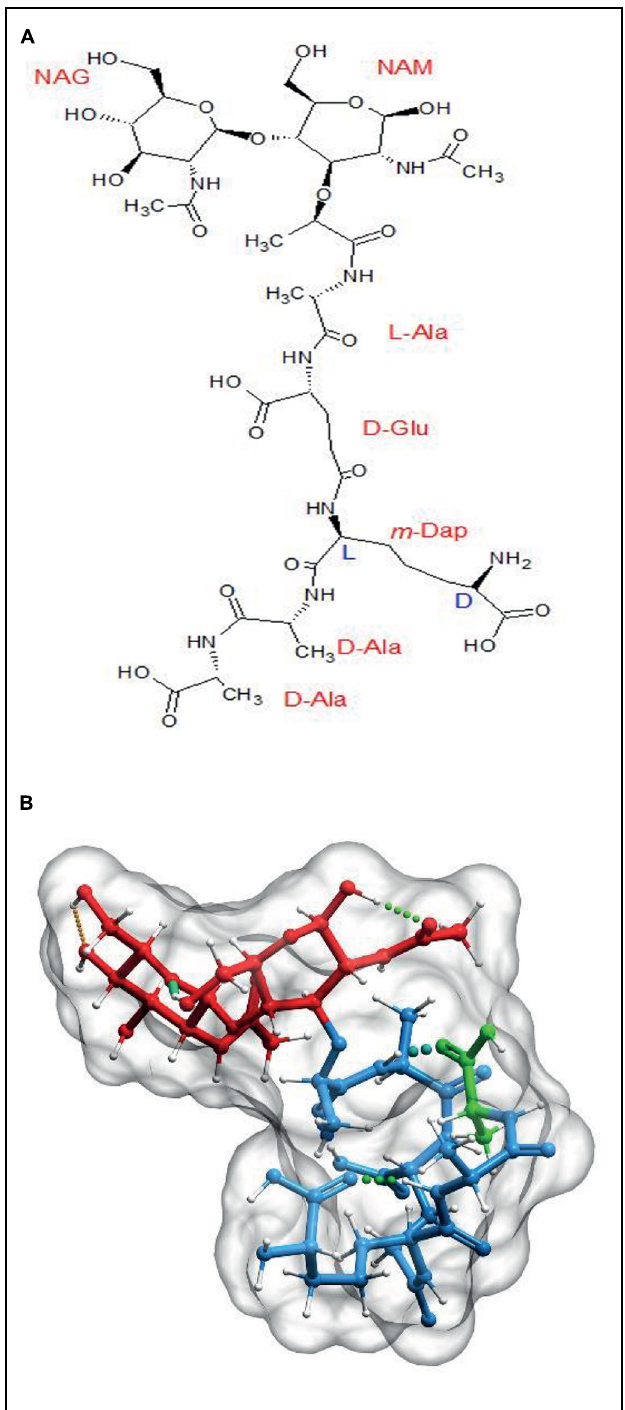
FIGURE 1 | The basic PG subunit. (A) Explicit formula for N -acetyl -glucosaminyl-( β ,1 −→ 4)- N -acetyl-muramyl- L -Alanyl- D -Glutaminyl( γ )- L -(meso) diaminopimelyl- D -alanyl- D -alanine (disaccharide–pentapeptide or M5). (B) Computer generated 3D representation of the same molecule after energy optimization. Red signals the glycan part, blue the stem peptide and green the terminal D -ala residue. Molecules were generated with Chemsketch (http://www.acdlabs.com/resources/freeware/chemsketch/), subjected to geometry and molecular mechanics optimization with Avogadro